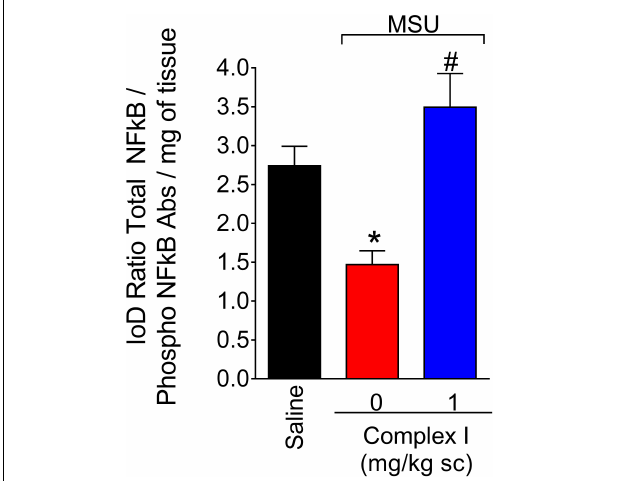
FIGURE 7 | Complex I reduces MSU-induced NF- κ B activation in the knee joint. Mice were treated with complex I (1 mg/kg/saline, s.c.) or vehicle 30 min prior to intra-articular injection of MSU (100 µ g/10 µ l) and after 15 h knee joints samples were collected to measurement of phosphorylated and total NF- κ B. Results are expressed as mean ± SEM ( n = 6 per group per experiment, representative of two experiments). ∗ p < 0.05 compared to saline group and # p < 0.05 compared to MSU + vehicle. One-way ANOVA followed by Tukey’s test.